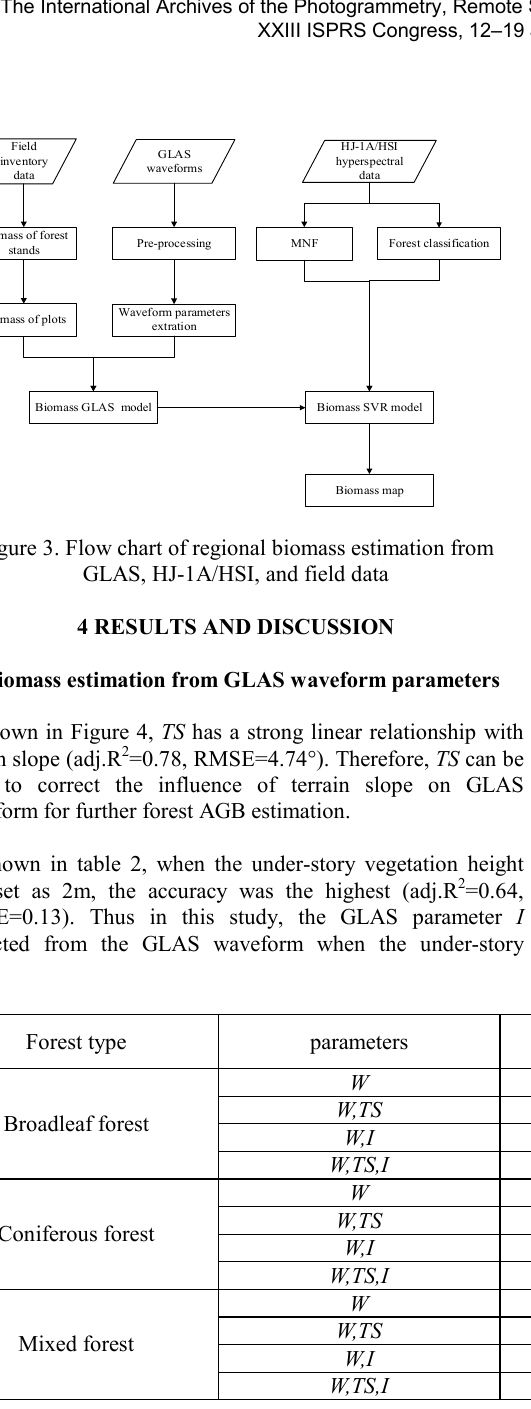
Table.3 Results of AGB estimation models with GLAS parameters